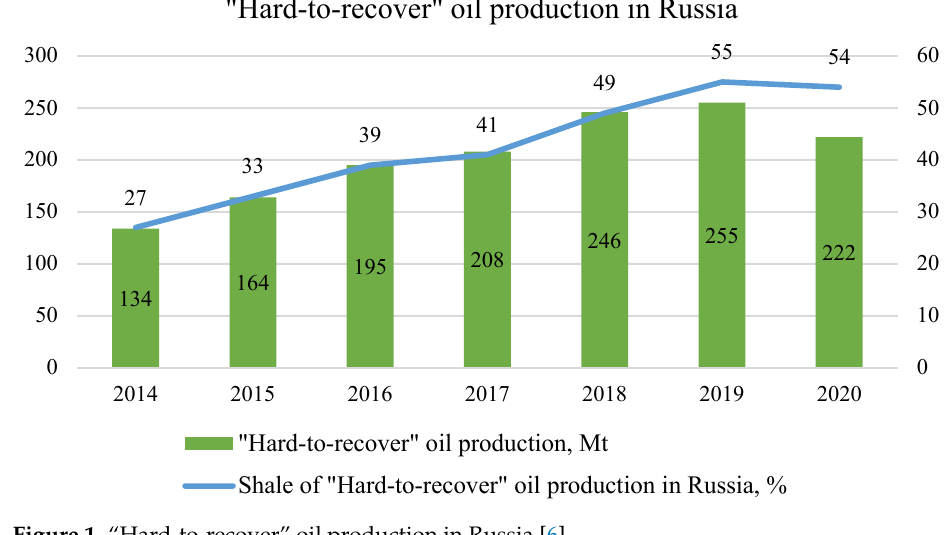
Figure 1. “Hard-to-recover” oil production in Russia [6].